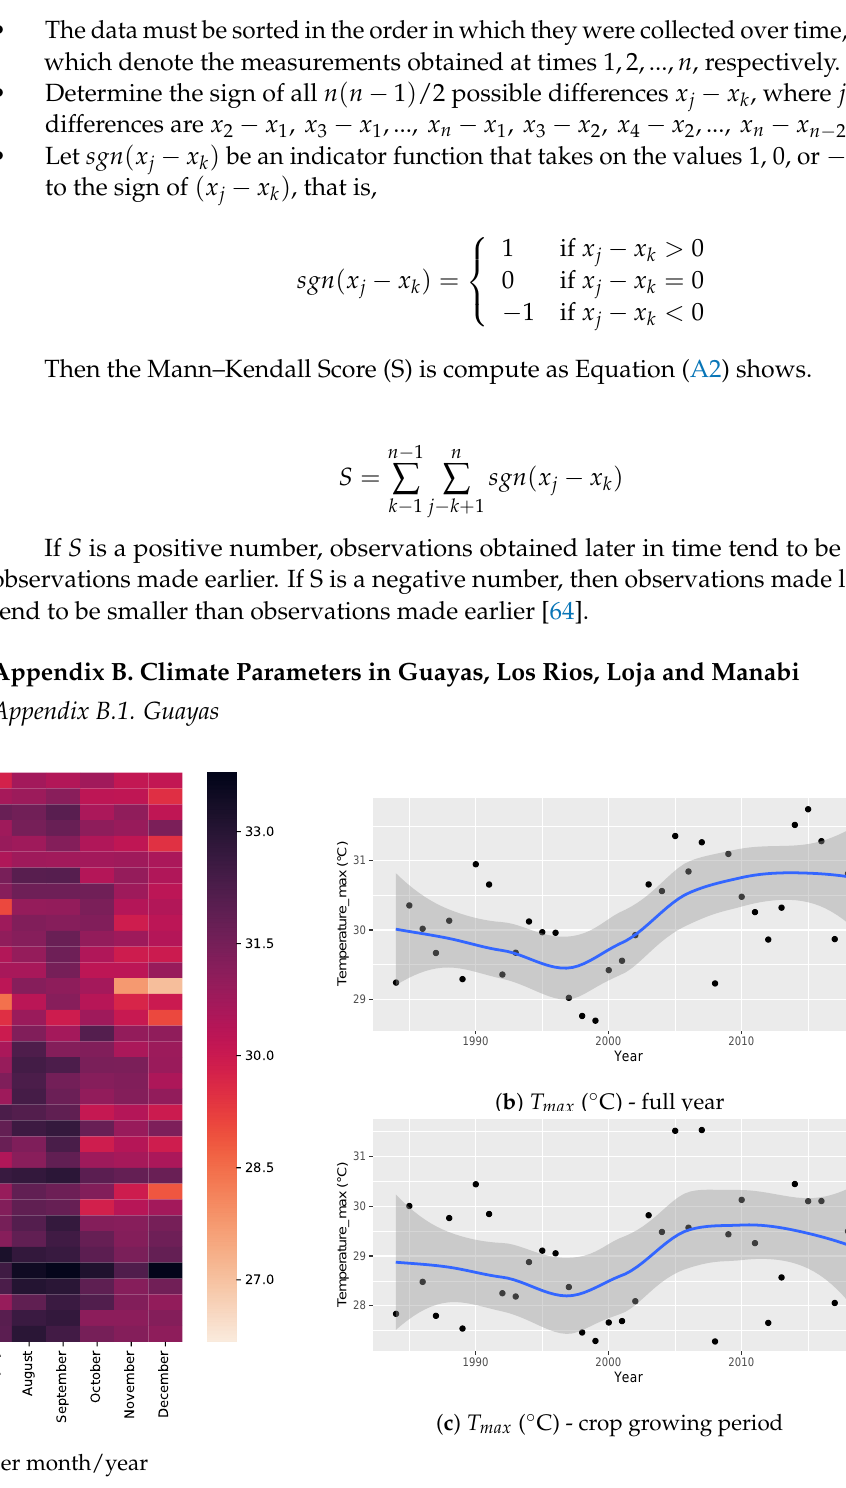
Figure A1. Time series of average maximum temperature ( ◦ C) in Guayas from 1984 to 2019. ( a ) Heat-map of T max ( ◦ C) per each month and year. The color scale represents the temperature in ◦ C. ( b ) T max ( ◦ C) averaged during the full year. ( c ) T max ( ◦ C) averaged during the maize crop growing period in Ecuador (January–May). Each dot represents one record, the blue line shows the smoothed time series and the shaded area represents the 95% confidence